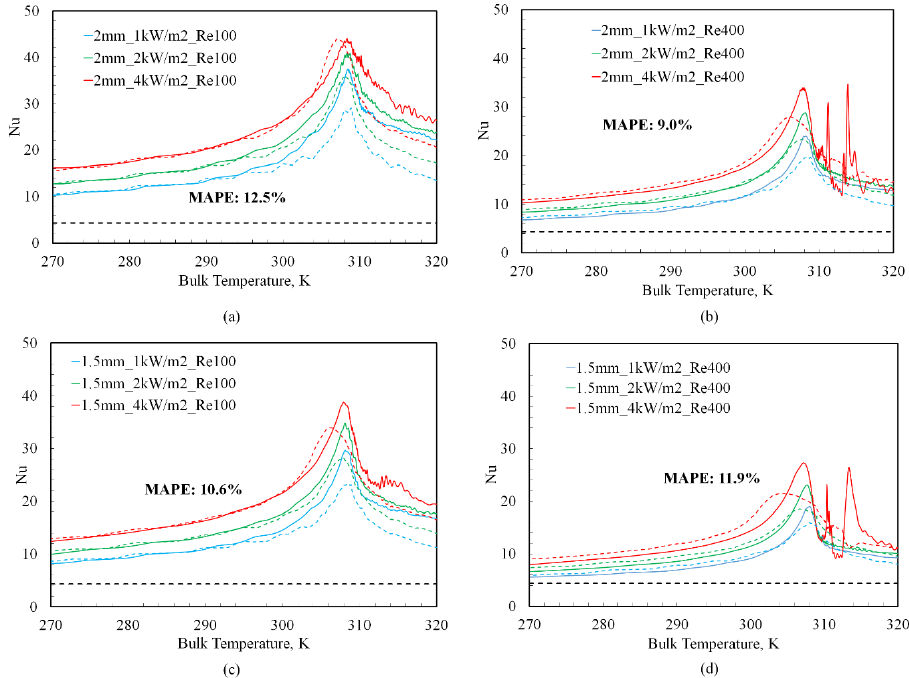
Figure 8. Equation (11) based predictions of Nu (dotted lines) versus bulk temperature (T BULK ) at tube diameters of 2 mm and 1.5 mm and different inlet Re: ( a ) 2 mm, Re 100; ( b ) 2 mm, Re 400; ( c ) 1.5 mm, Re 100; ( d ) 1.5 mm, Re 400. CFD-based Nu calculations are shown in bold lines. The values of B in Equation (11) were: 0.39 for T BULK < T PC and 0.39 for T BULK > T PC.